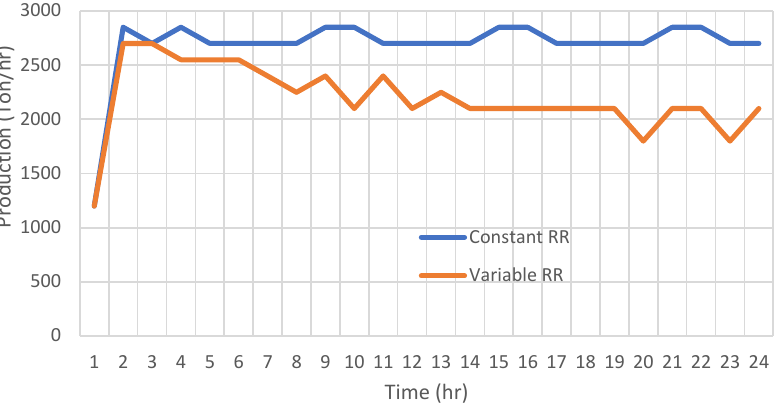
Figure 7. Production expressed in Ton/Hr between a model that does not consider the RR of the road over time (constant RR), and a model that does consider this phenomenon (variable RR).